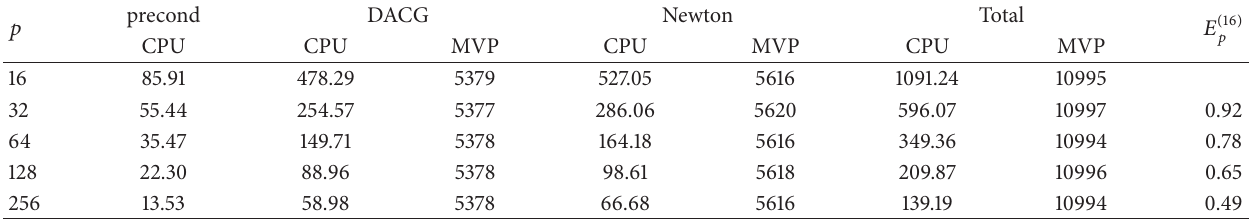
Table 7: Iterations, timings, and pseudo efficiencies for problem EMILIA-923